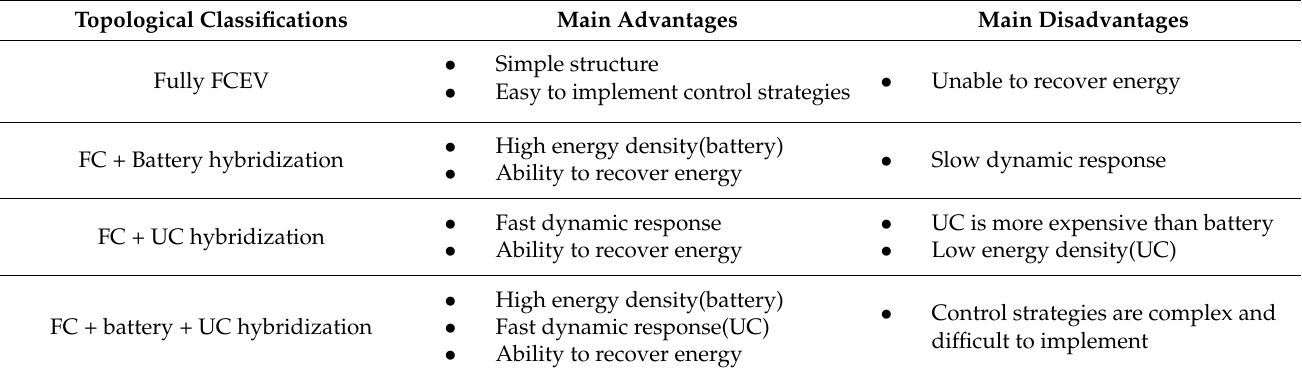
Table 1. Summary of common FCHEVs’ topologies.